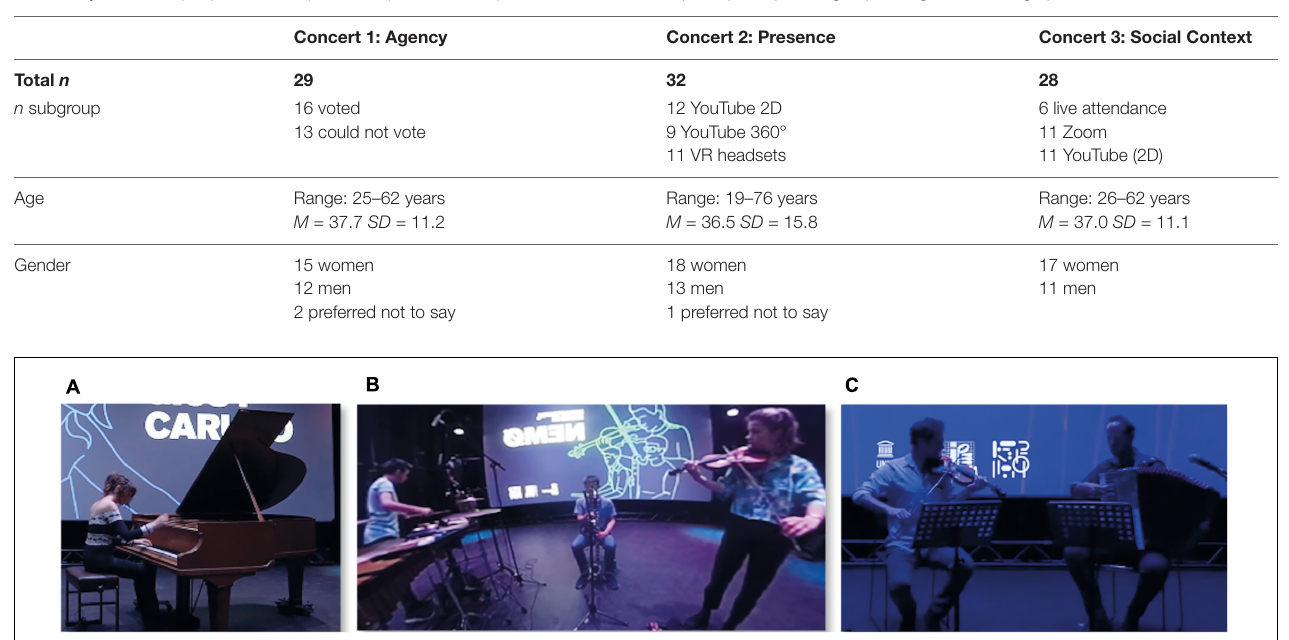
FIGURE 1 | Snapshots of the three livestreamed concerts in order of occurrence. (A) Concert 1: Agency, (B) Concert 2: Presence, (C) Concert 3: Social Context. The snapshots of the first (A) and third (C) concerts provide a standard perspective, while the second snapshot comes from the livestream with 360 view (B)